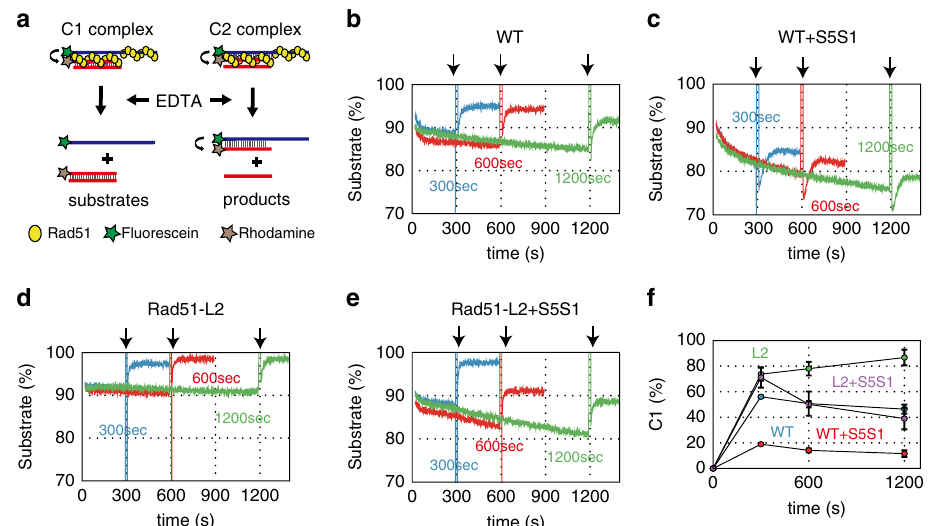
Fig. 3 A pairing-initiated abortive DNA strand exchange assay indicates that C1 intermediates accumulate in the L2 loop mutant. a Schematic diagram of a pairing-initiated abortive DNA strand exchange assay. EDTA was added to the ongoing pairing reactions to chelate Mg 2 + , leading to dissociation of Rad51 from the intermediates. Fluorescence emission increases if the C1 intermediate is converted to substrates, but does not change substantially if the C2 intermediates are converted to products. b – e Time courses of the pairing-initiated abortive assay: b wild-type Rad51; c wild-type Rad51 with Swi5-Sfr1; d Rad51-L2; and e Rad51-L2 with Swi5-Sfr1. EDTA was added in the reaction mixture 5 (blue), 10 (red), or 20 (green) min, as indicated by arrows, after the strand pairing reaction started. f Time course of accumulation (% of the input) of the C1 intermediate. wild-type Rad51; blue, wild-type Rad51 with Swi5- Sfr1; red, Rad51-L2; green and Rad51-L2 with Swi5-Sfr1; purple. Data are expressed as the mean ± s.d. ( n = 3 independent experiments). Source data are provided as a Source data fi